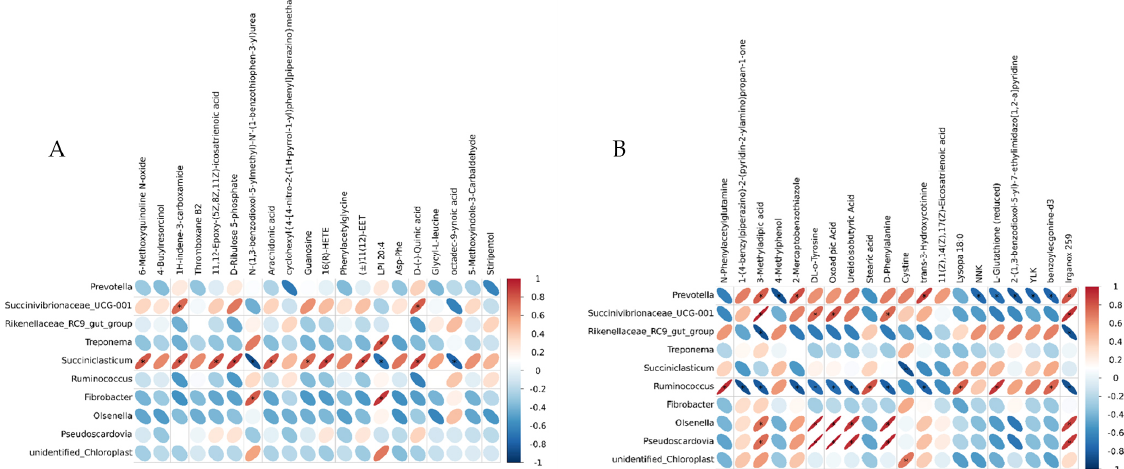
Figure 6. Correlation analysis between differential OTUs and metabolites. ( A ) CON-HG correlation analysis heat map. ( B ) HG-HGE correlation analysis heat map.